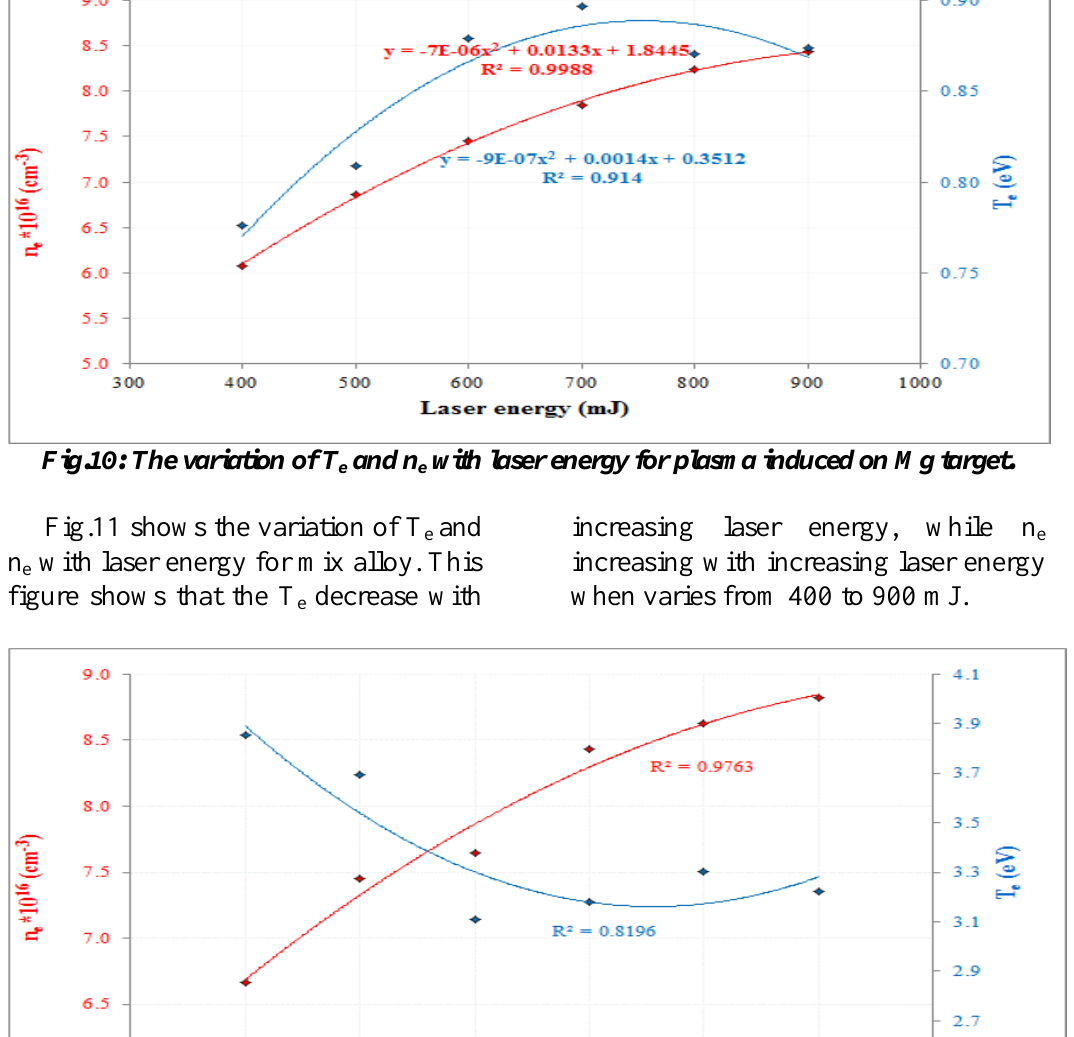
and n with laser energy for plasma induced on Mg:Al e e